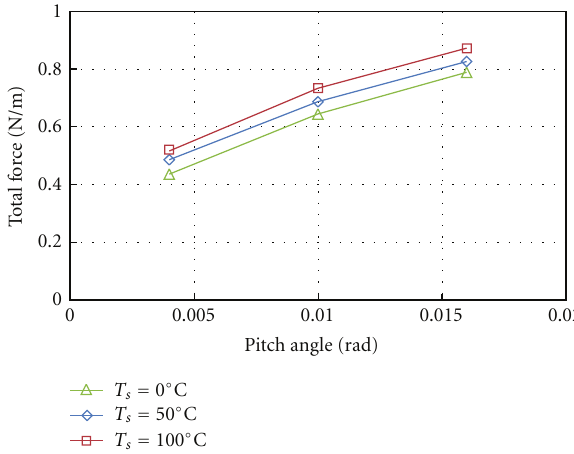
Figure 9: Comparison of total bearing forces acted on the slider surface with di ff erent slider temperatures and slider pitch angles.